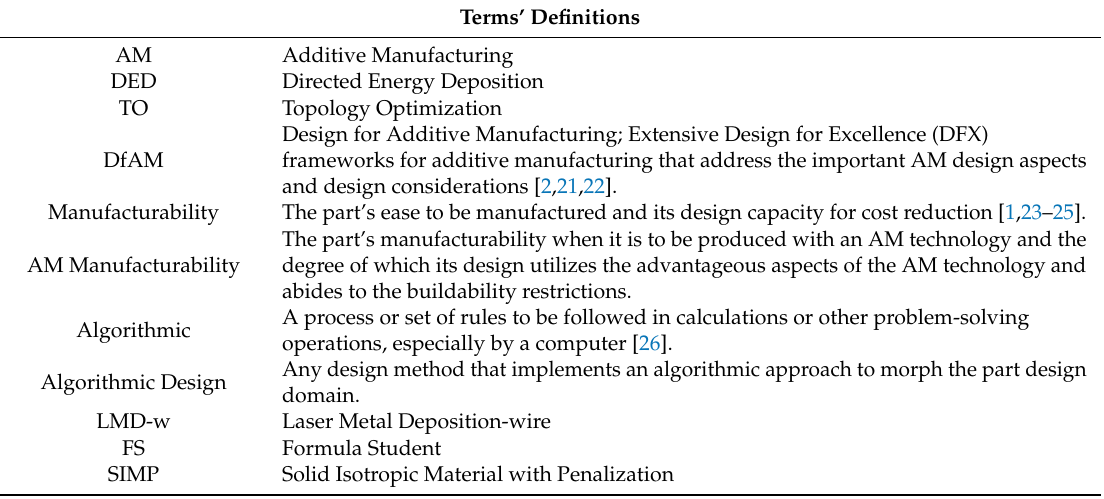
Table 2. Definition of